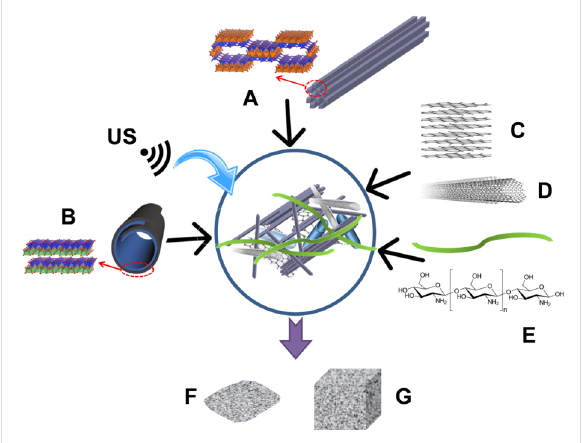
Figure 1: Schematic representation of the different components inte- grated in the bionanocomposite materials, i.e., (A) sepiolite fibrous clay, (B) halloysite nanotubes, (C) graphene nanoplatelets, (D) multi- walled carbon nanotubes, and (E) chitosan biopolymer, prepared